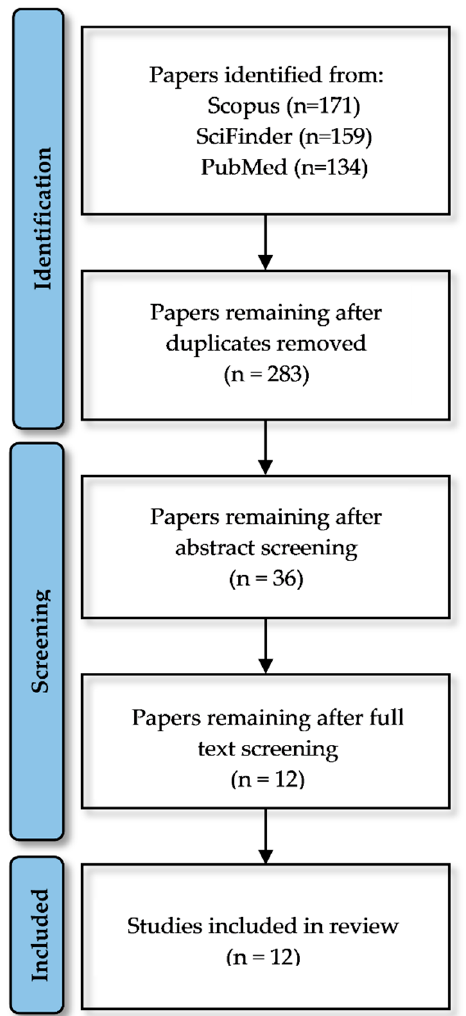
Figure 2. A summary of the papers considered in each stage of the review process. Studies combining early-stage drug discovery and preclinical studies are very limited, resulting in 12 studies to be included in the review.